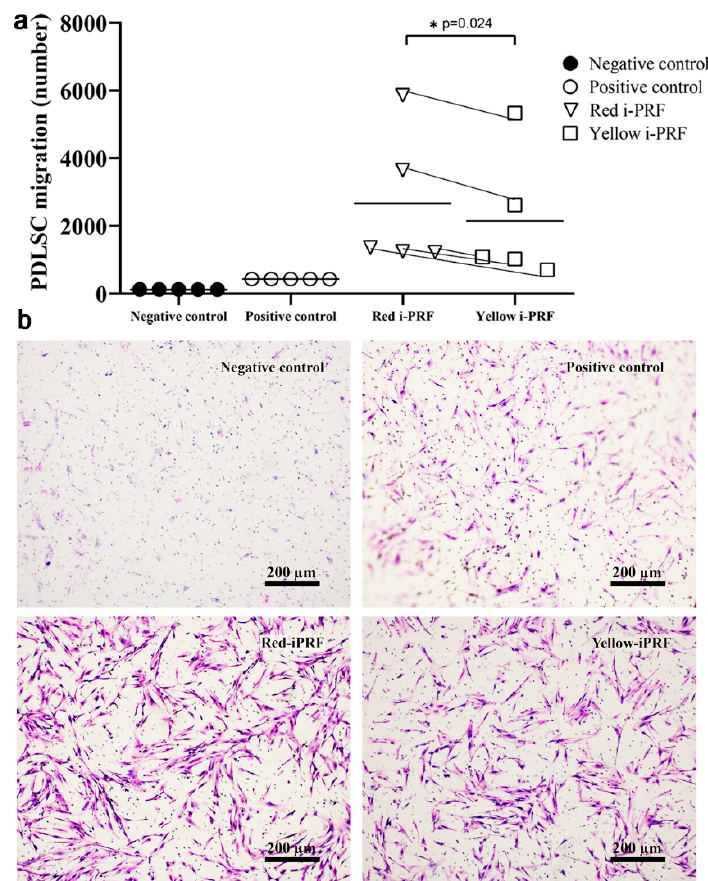
Figure 3. Migration of periodontal ligament stem cells. Conditioned medium obtained from the release from red or yellow i-PRFs was loaded into the growth medium supplemented with fetal bovine serum as the positive control. The medium without any supplement was the negative control. The number of migrated cells was significantly higher in the red i-PRF group than the yellow i-PRF group as shown ( a ) quantitatively and ( b ) microscopically (scale bar = 200 µ m). Significance was assessed using one-way ANOVA followed by post hoc least-significant di ff erence tests to compare the di ff erences between groups. The data are shown as individual donor pairs. * p < 0.05.